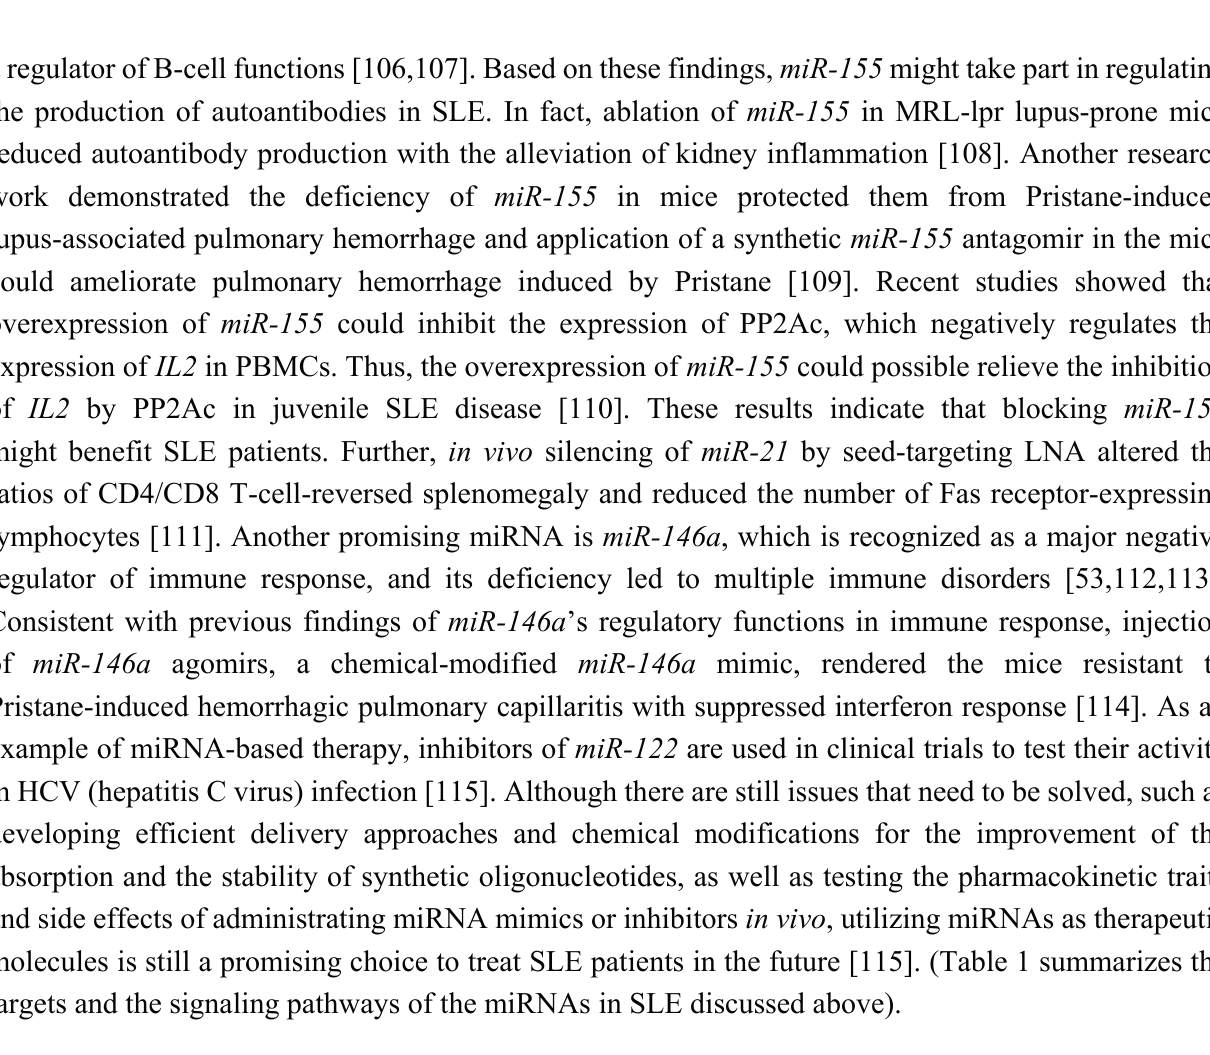
Table 1. miRNAs in the pathogenesis of systemic lupus erythematosus